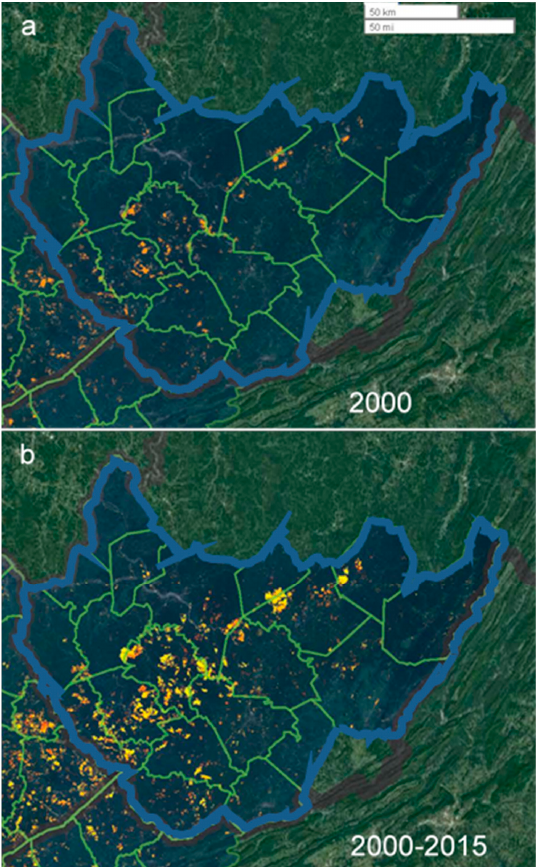
Figure 1. Surface mining in Southern West Virginia 2000–2015. Composite satellite and data analysis overlay images captured from the SkyTruth website, which depict the location and extent of mountaintop mining (MTM) operations in central Appalachia from 1985 to 2015. The 19 Southern West Virginia counties that were studied here are outlined in blue. Individual counties are outlined in green. We have added the overlay of dates to illustrate which years we have captured. ( a ) Location and extent of central Appalachian MTM as seen in the year 2000 and ( b ) 2000–2015 (cumulative). Hotter (redder) colors indicate data that are more recent. Scale bars = 50 km (top) and 50 miles (bottom) respectively. Source: SkyTruth mountaintop mining (MTM) http: // Skytruthmtr.appspot.com / #closecontent. Map